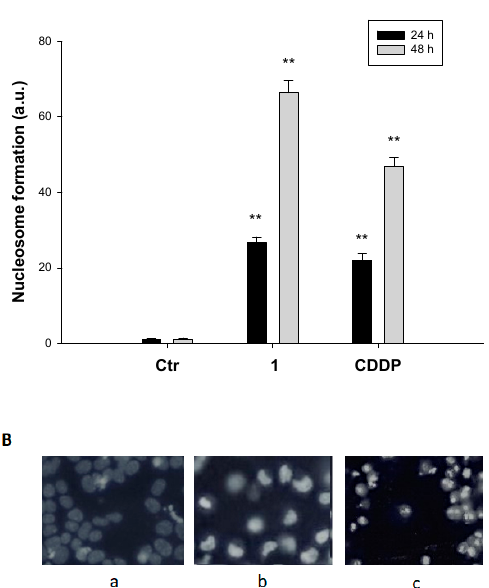
Figure 4. DNA fragmentation and apoptosis induction. ( A ) Nuclear DNA fragmentation. HCT-15 cells were treated for 24 or 48 h with IC 50 of 1 or CDDP. Quantitative estimation of DNA fragmentation was obtained with an ELISA test. Error bars indicate SD. ** p < 0.01. ( B ) HCT-15 cells were treated with IC 50 of 1 or CDDP for 48 h and stained with the fluorescent dye Hoechst 33258. ( a ) control cells; ( b ) CDDP-treated cells; ( c ) 1 -treated cells.